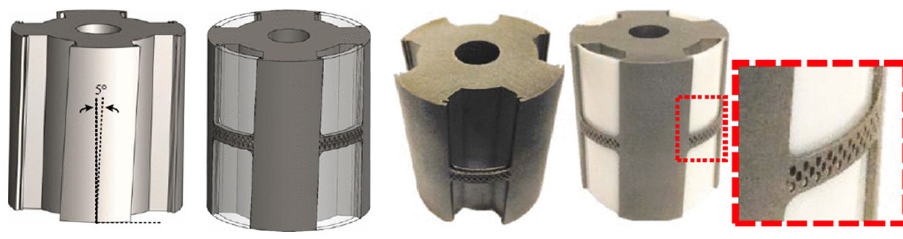
Figure 11. AM-built, Novel SRM-Rotor